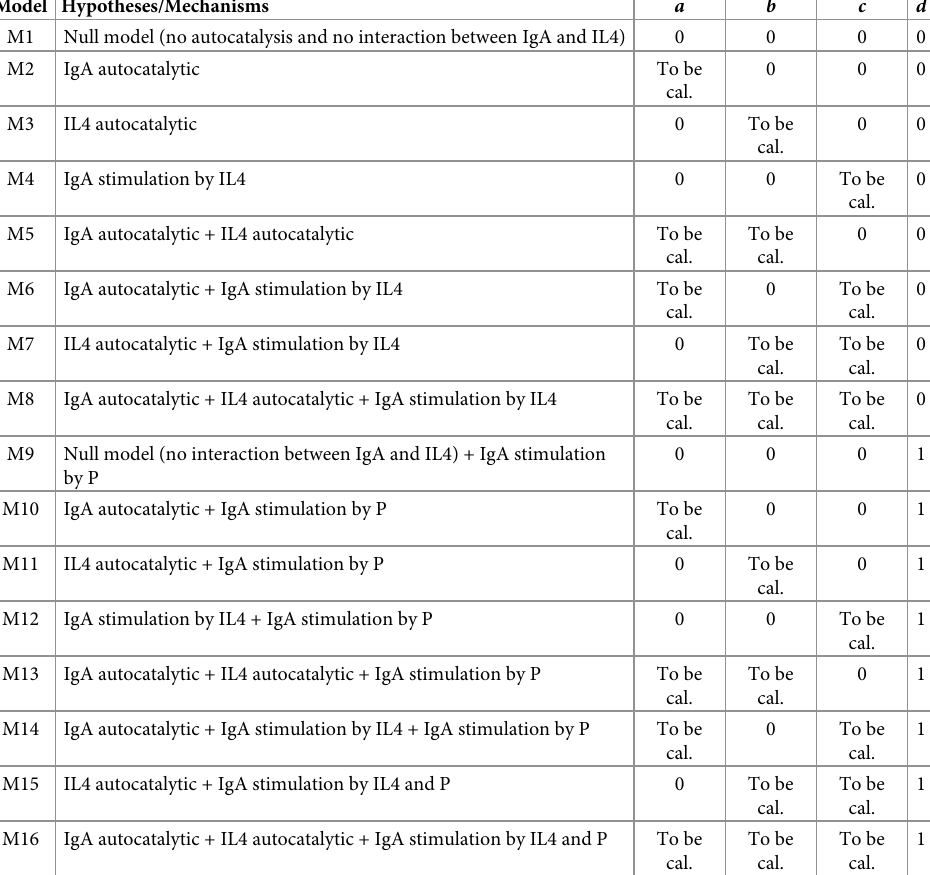
and IL4, � I , at the site of the infection 1 i 2 i , and IL4, δ , 1 i 2 i and Λ is esti- 1 i 2 i , α , β , β , a , 1 i 2 i i i i and I . 1 2